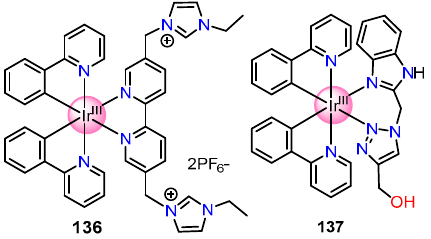
Figure 19. Structures of Ir(III) complexes 136 – 137